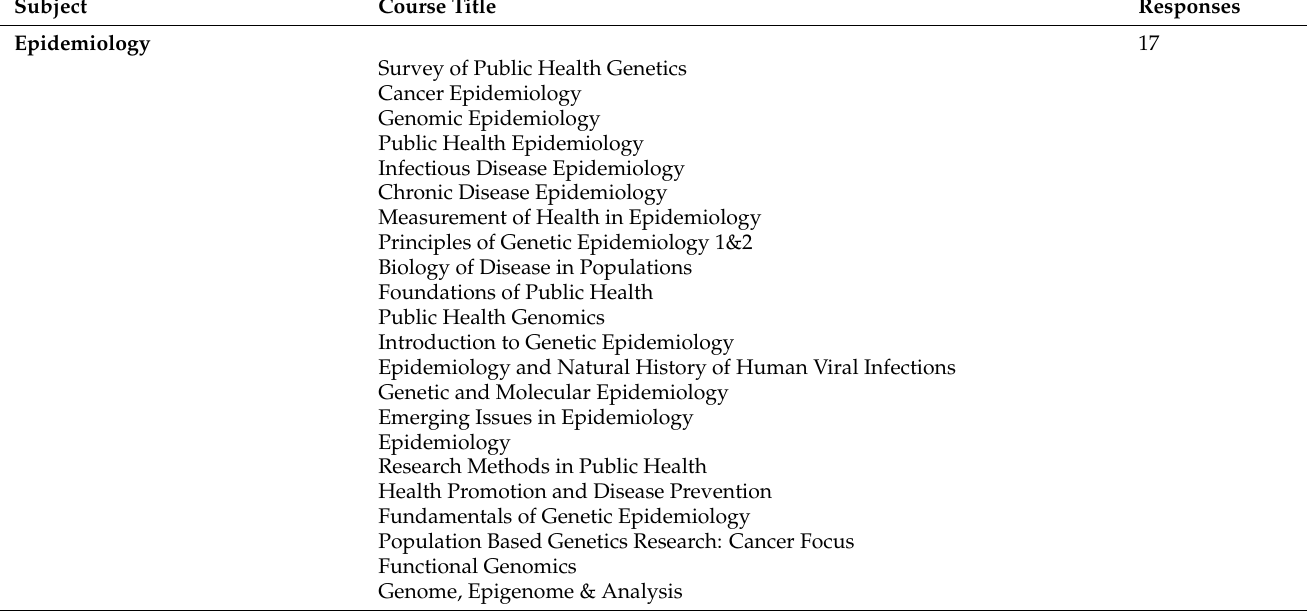
Table 4. Titles of current courses which contain an element of